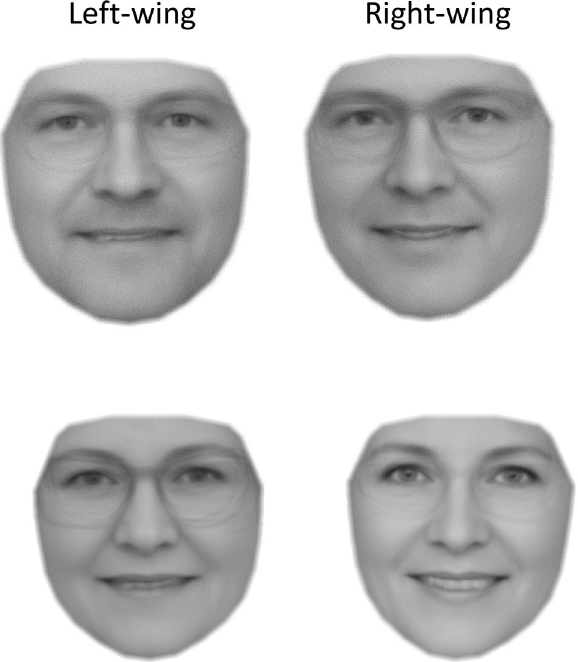
Figure 5. Facial averages for males and females Note. Facial averages for the candidates with the 20 most extreme scores on predicted ideology for each gender. E.g., the facial average of the 20 male candidates with the most extreme predicted left-wing beliefs are top